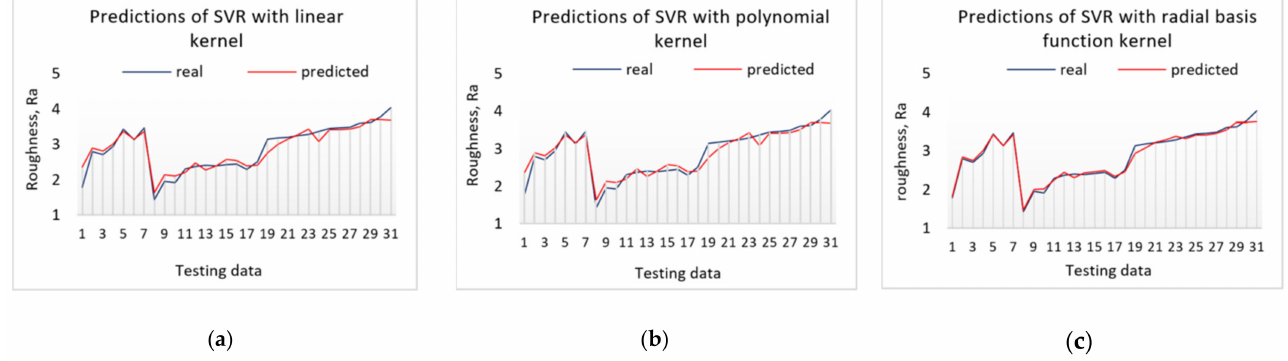
Figure 20. Testing results of the SVM model with different kernels: ( a )—linear, ( b )—polynomial, ( c )—radial basis